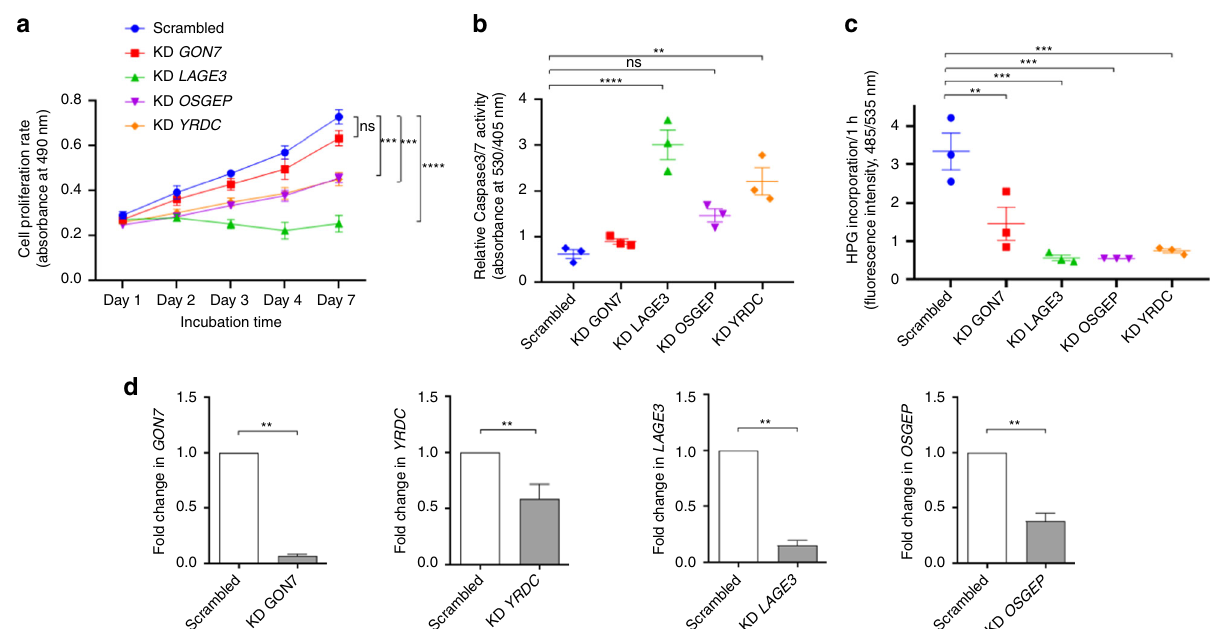
Fig. 4 Proliferation, apoptosis, and protein synthesis defects upon GON7 and YRDC knockdown. Transient knockdown (KD) of GON7 , LAGE3 , YRDC, and OSGEP was performed by lentiviral transduction of shRNA in immortalized human podocyte cell lines with a scrambled (non-targeting) shRNA as control. a Cell proliferation was assessed using a colorimetric MTT assay over 7 days, measuring absorbance at 490 nm at days 1, 2, 3, 4, and 7 (mean ± s.e.m. of n = 5 experiments, with each experiment performed in triplicate; two-way ANOVA ( p < 0.0001), Dunnett ’ s multiple comparisons test, n.s. = 0.2031, *** p < 0.0007, **** p < 0.0001). b Cell apoptosis was evaluated by quanti fi cation of caspase 3/7 activation on the basis of fl uorescence intensity (530/405 nm). Absolute values were normalized to DAPI fl uorescence intensity as an internal control and compared to non-targeting shRNA-treated control cells (scrambled) (mean ± s.e.m. of n = 3 experiments with each experiment performed in triplicate; one-way ANOVA ( F (4,10) = 21.42, p < 0.0001), Dunnett ’ s multiple comparisons test, n.s. = 0.0556, ** p = 0.0012, **** p < 0.0001). c Protein biosynthesis rates were assessed on the basis of incorporation of HPG, an alkyne-containing methionine analog. After 2 h, alkyne-containing proteins were quanti fi ed on the basis of fl uorescence intensity (485/535 nm). Absolute values were normalized to DAPI fl uorescence intensity as an internal control and compared to control cells (mean ± s.e.m. of n = 3 experiments, with each experiment performed in triplicate, one-way ANOVA ( F (4,10) = 16.36, p = 0.0002), Dunnett ’ s multiple comparisons test, ** p = 0.0035, **** p < 0.0003). d Relative expression of GON7 , YRDC , LAGE3 , and OSGEP transcripts were normalized to that of HPRT in KD podocytes compared to non- targeting shRNA control treated cells (mean ± s.e.m. of n = 5 experiments, with each experiment being performed in triplicate; two-tailed Mann – Whitney test, ** p < 0.05). Source data are provided as a Source Data fi